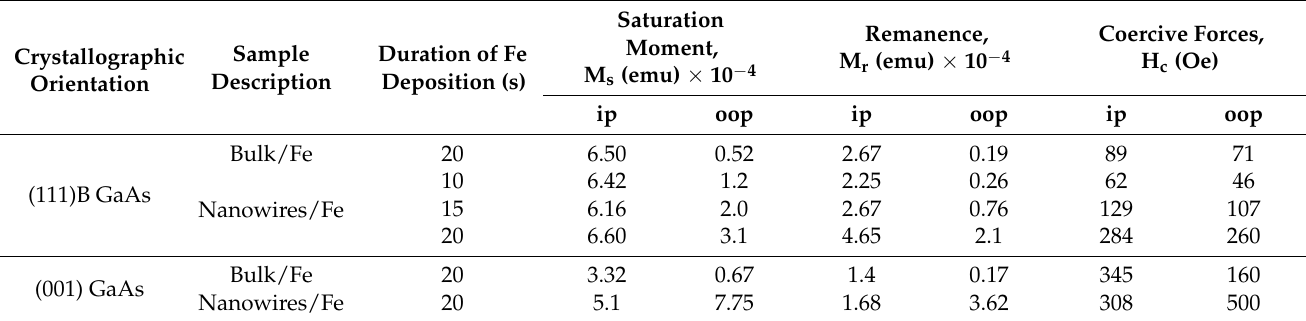
Table 1. Saturation moment, remanence, and coercive forces for electrochemically deposited Fe on bulk and porous GaAs samples for in-plane and out-of-plane VSM measurements.